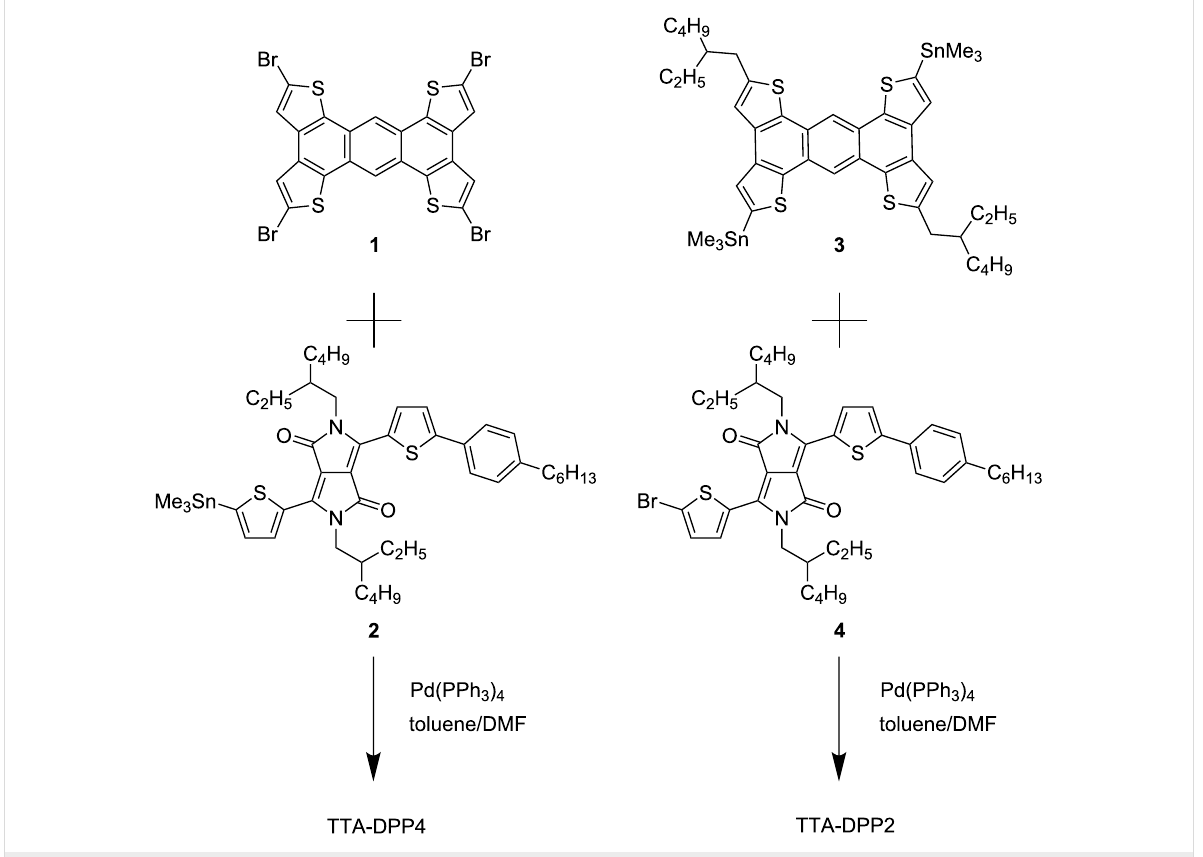
Scheme 1: Synthesis of TTA-DPP4 and TTA-DPP2.